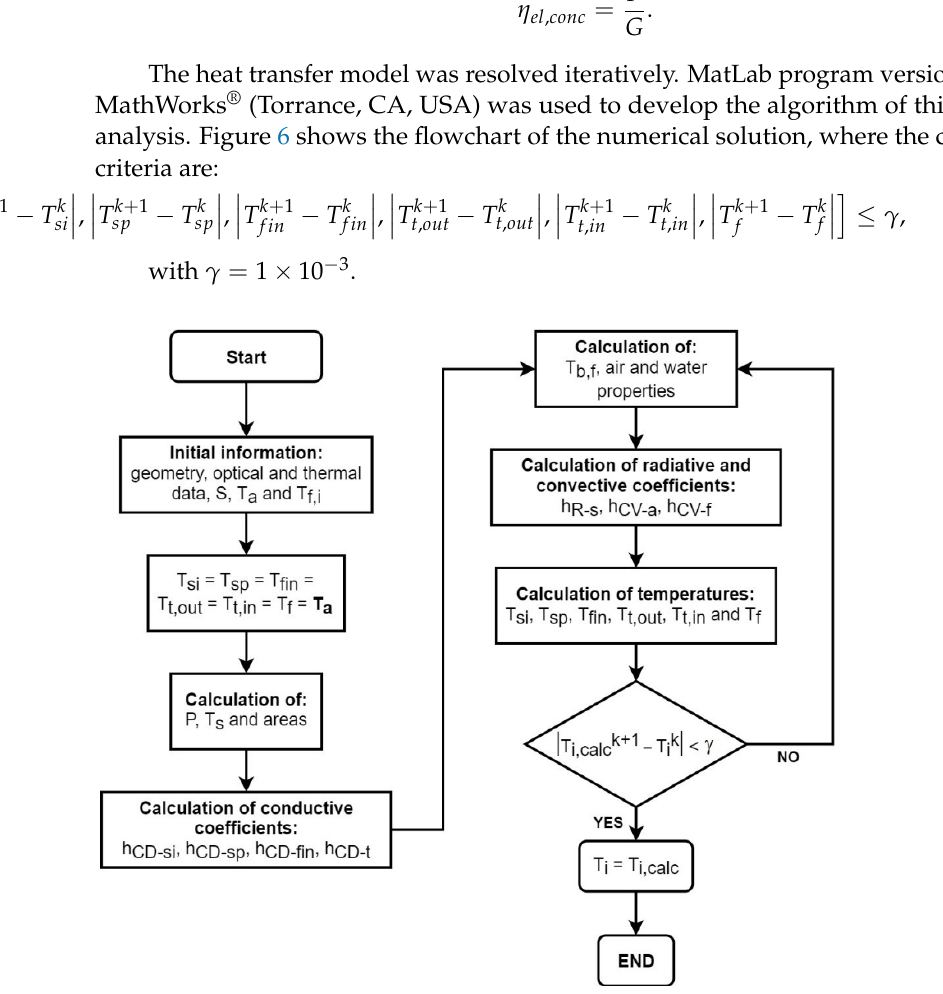
Figure 6. Flowchart of the heat transfer model.